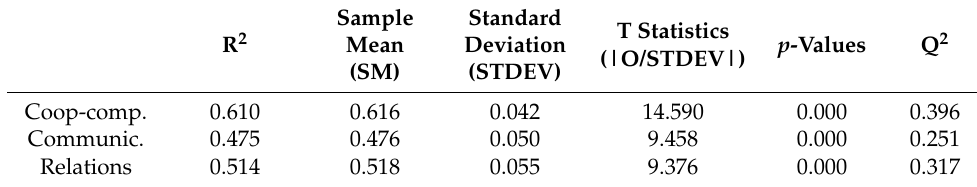
Table 4. Structural model